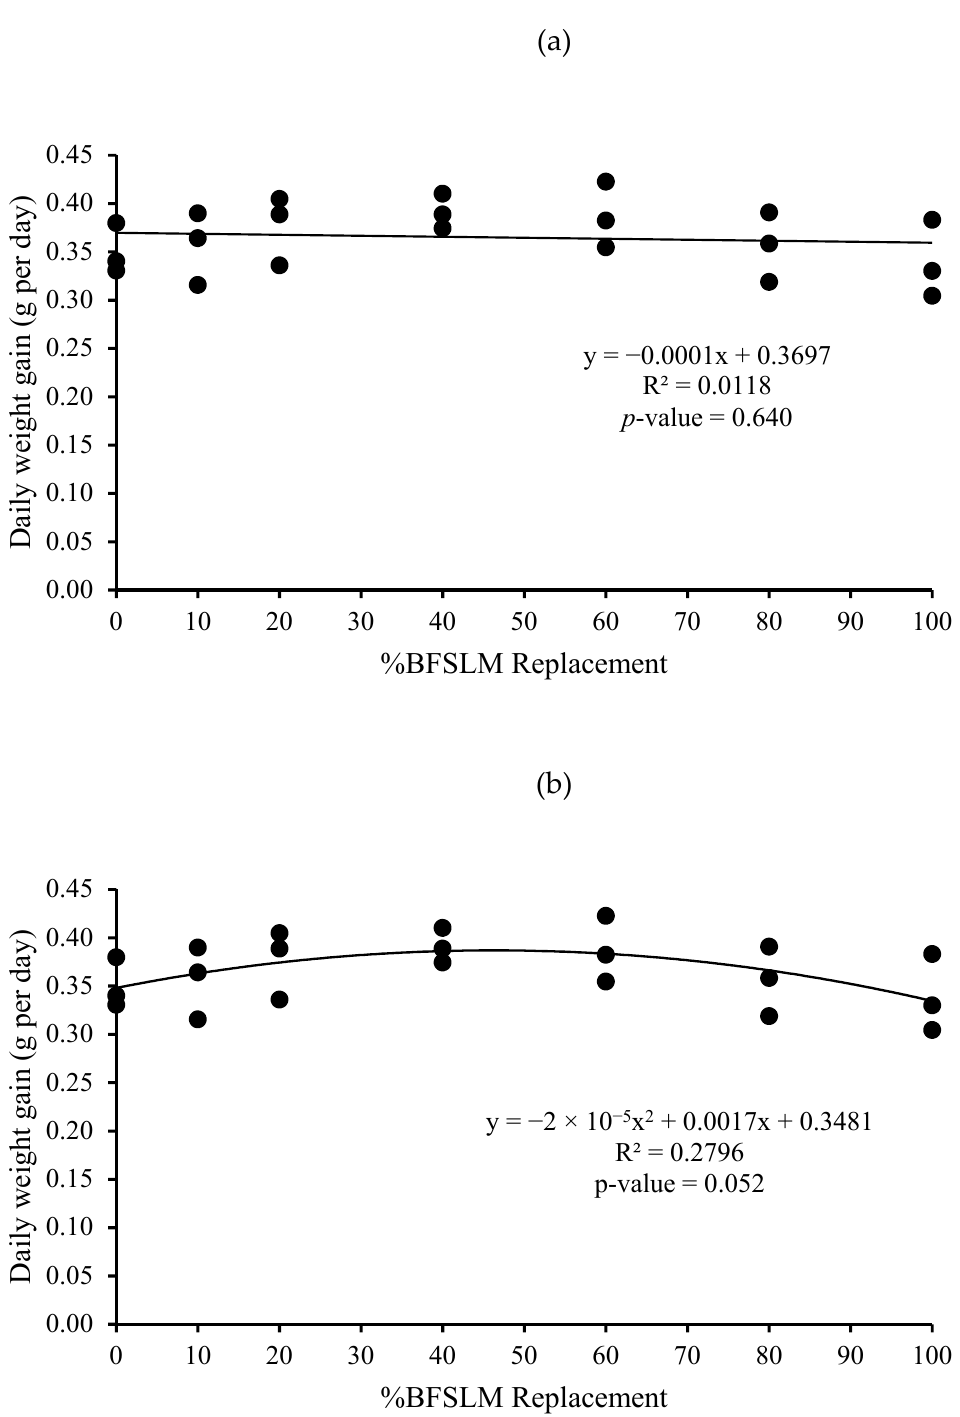
Figure 3. Linear ( a ) and quadratic ( b ) estimate: When X = %BSFLM replacement; Y = Daily weight gain after 12 weeks of feeding with control (0% BSFLM and 100% FM), and FM replaced at 10%, 20%, 40%, 60%, 80%, and 100% of the BSFLM.